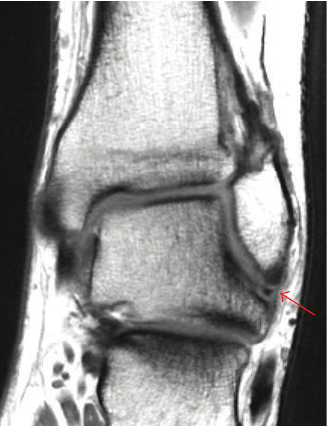
Figure 5: Coronal T1-weighted MR image showing an ATFL tear